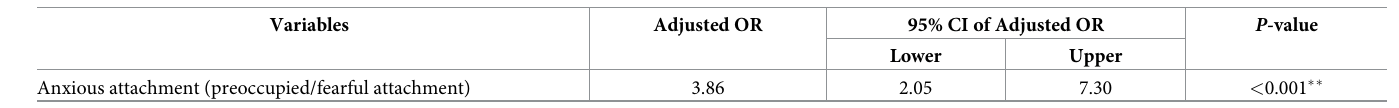
Table 5. Stepwise multiple logistic